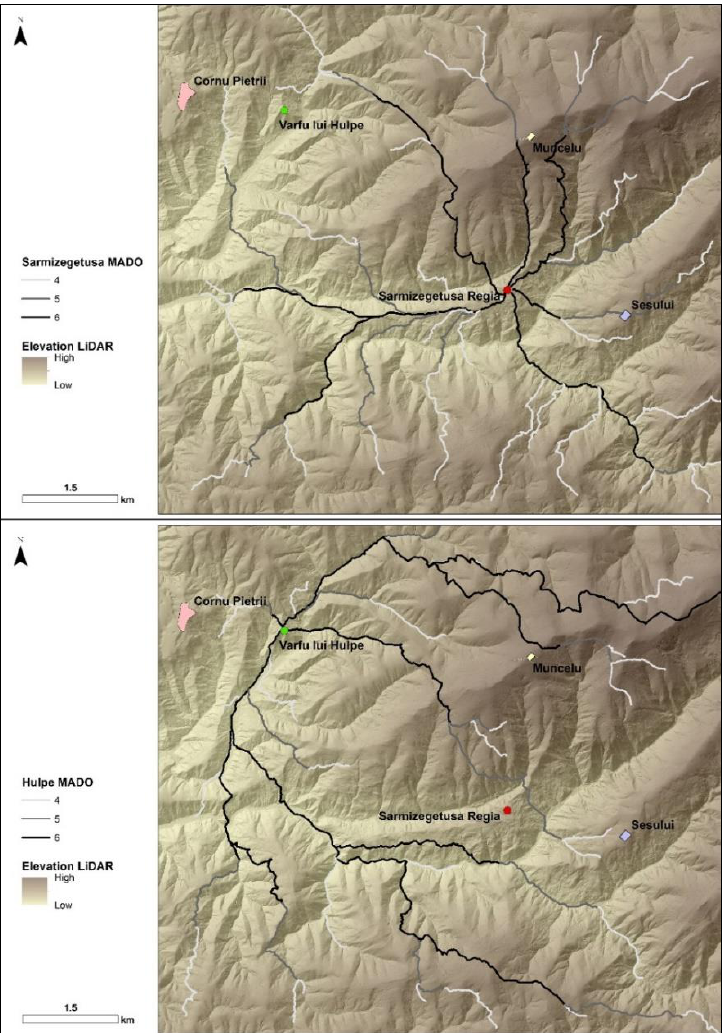
Figure 4. MADO (with the highest values of the focal mobility network 4 to 6) from Sarmizegetusa Regia ( above ); MADO from Vârfu lui Hulpe ( below ).